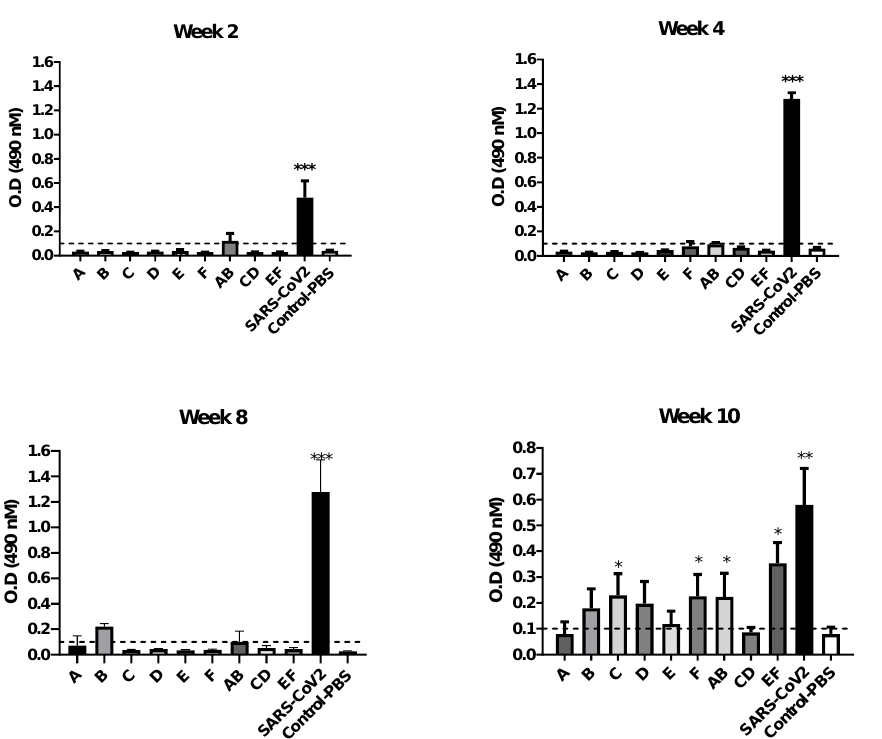
Figure 4. Optical density (O.D) obtained from ELISA for sera of BALB/C mice immunized with short-peptides from A to E and combination (AB, CD, EF) groups in comparison with SARS-CoV-2 inactivated vaccine. Cut-off value for assay validation = 0.1 O.D reading at 490 nM. Statistical changes marked by * p value < 0.05, ** p value < 0.01 and *** p value < 0.001.